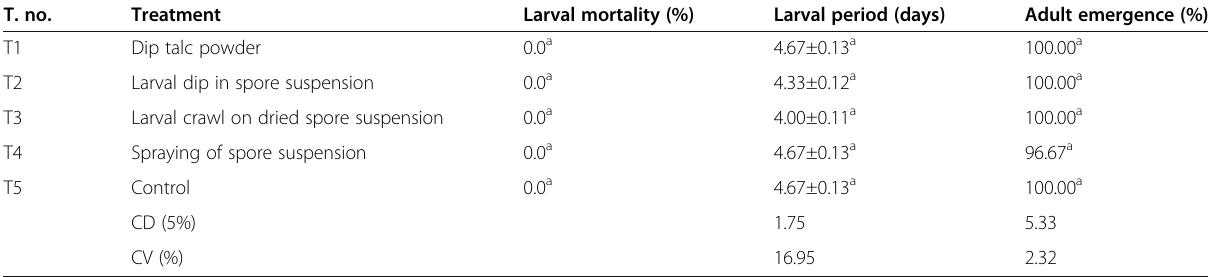
Table 10 Effect of Lecanicillium lecanii on some biological parameters of Neoseiulus longispinosus T.